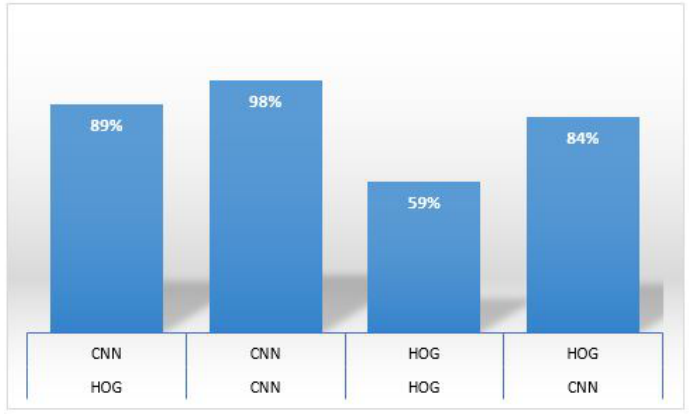
Figure 7. Comparison of HoG and CNN while Using Video to Detect